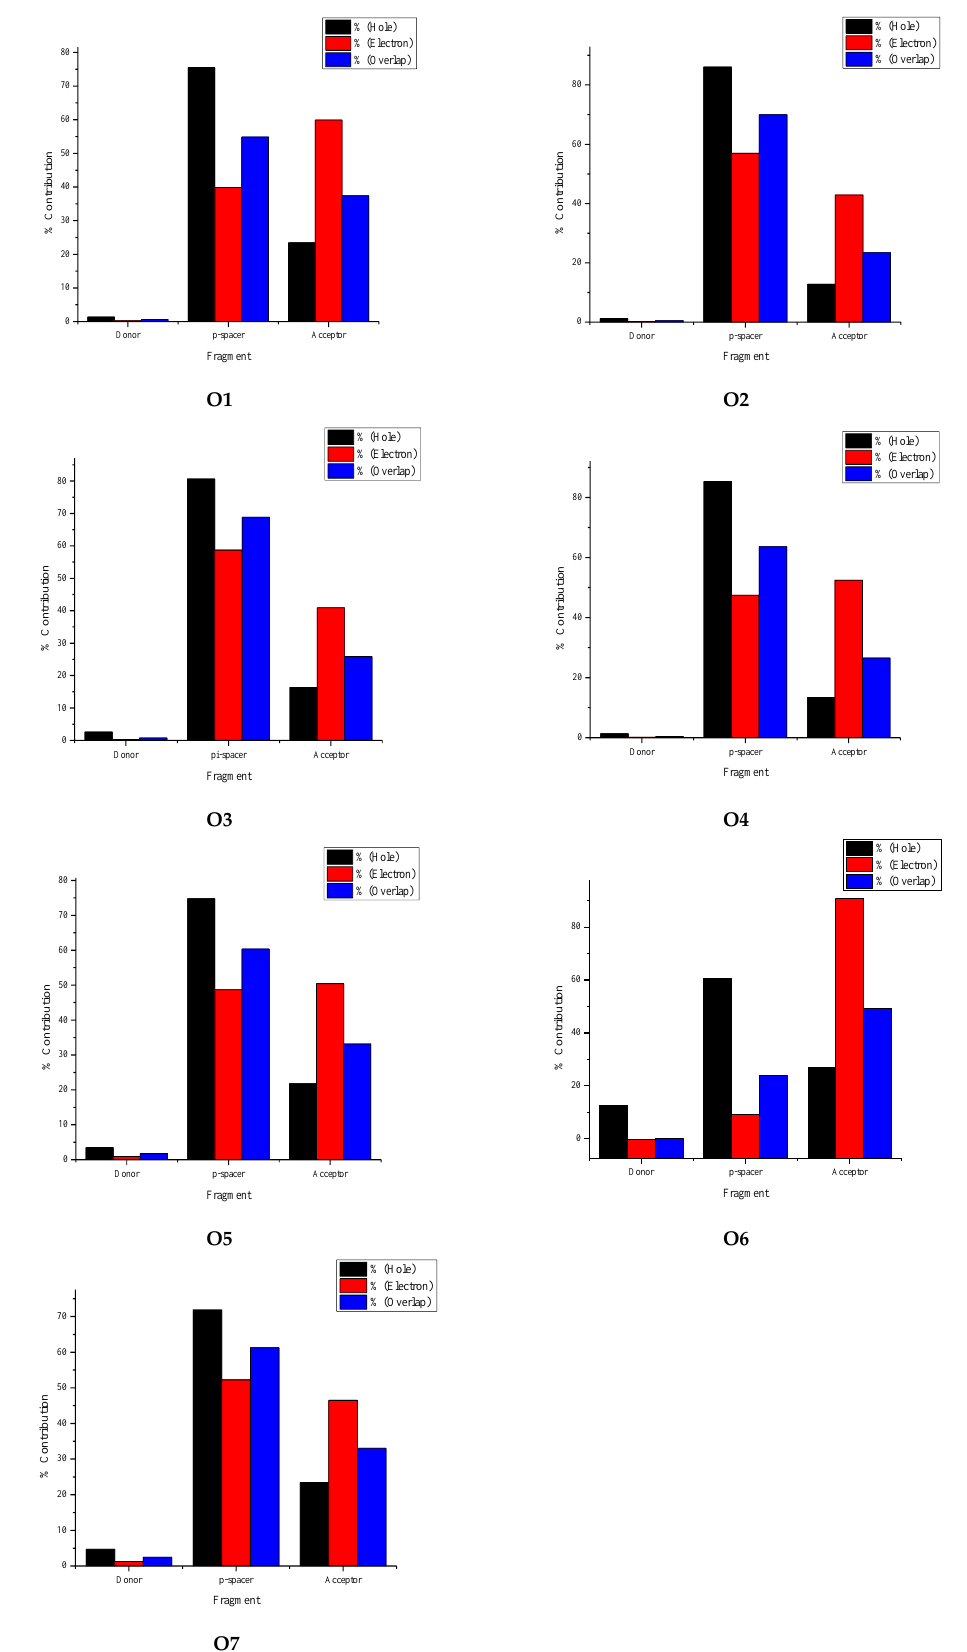
Figure 5. Electron – hole contribution to each fragment within each compound. Figure 5. Electron–hole contribution to each fragment within each Table 4. Fragment contribution to electron – hole overlap in O1.